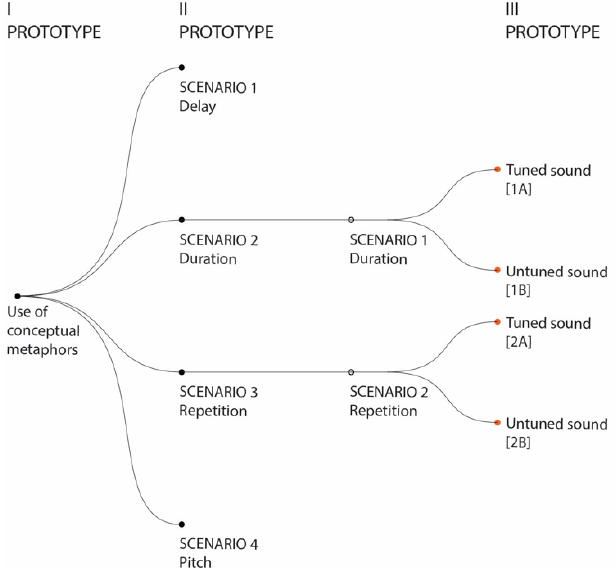
Figure 2. First Design Action. Prototypes iteration